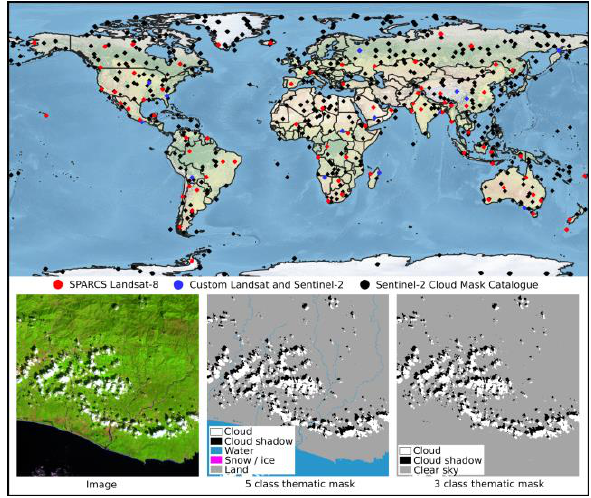
Figure 1. Spatial distribution of datasets used in this